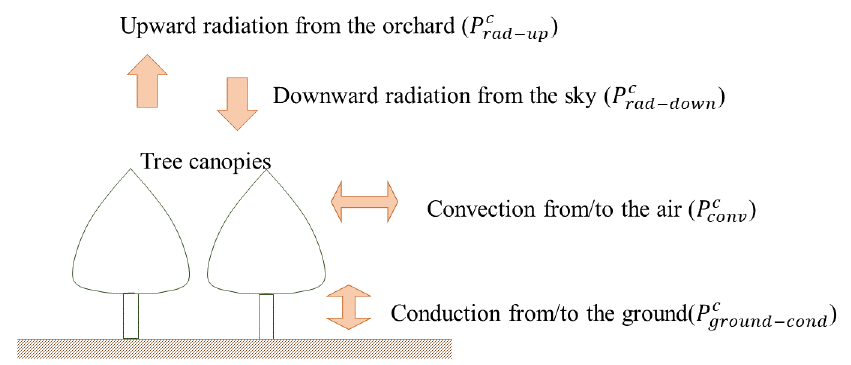
Figure 2. Energy flows around trees in a fruit orchard.